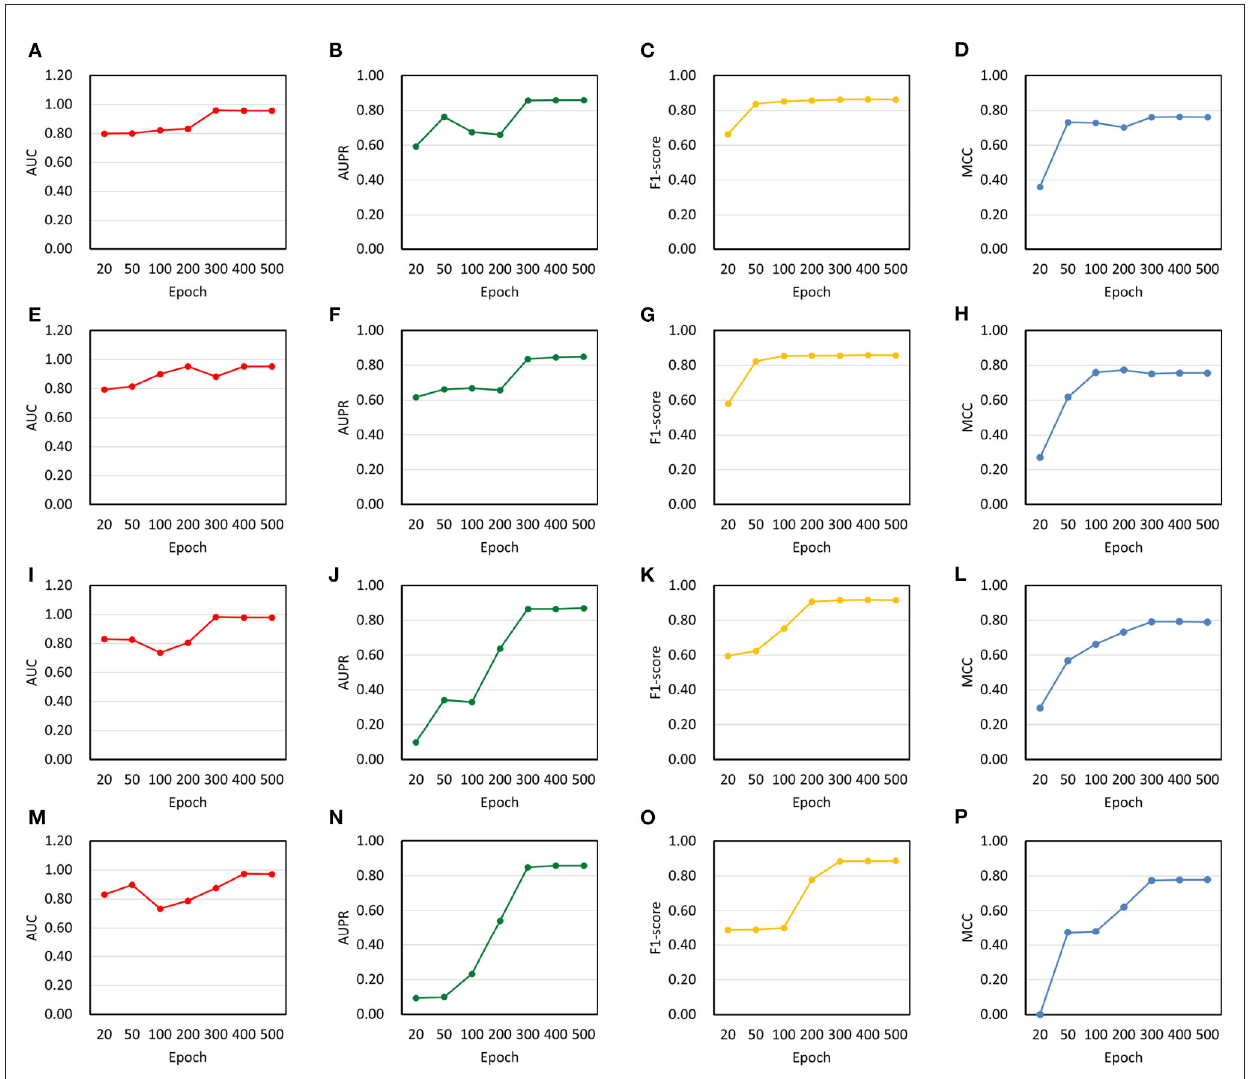
FIGURE3 Changes in model performance on balanced and unbalanced datasets. (A) AUC on balanced NoncoRNA. (B) AUPR on balanced NoncoRNA. (C) F1-score on balanced NoncoRNA. (D) MCC on balanced NoncoRNA. (E) AUC on unbalanced NoncoRNA. (F) AUPR on unbalanced NoncoRNA. (G) F1-score on unbalanced NoncoRNA. (H) MCC on unbalanced NoncoRNA. (I) AUC on balanced ncDR. (J) AUPR on balanced ncDR. (K) F1-score on balanced ncDR. (L) MCC on balanced ncDR. (M) AUC on unbalanced ncDR. (N) AUPR on unbalanced ncDR. (O) F1-score on unbalanced ncDR. (P) MCC on unbalanced ncDR.